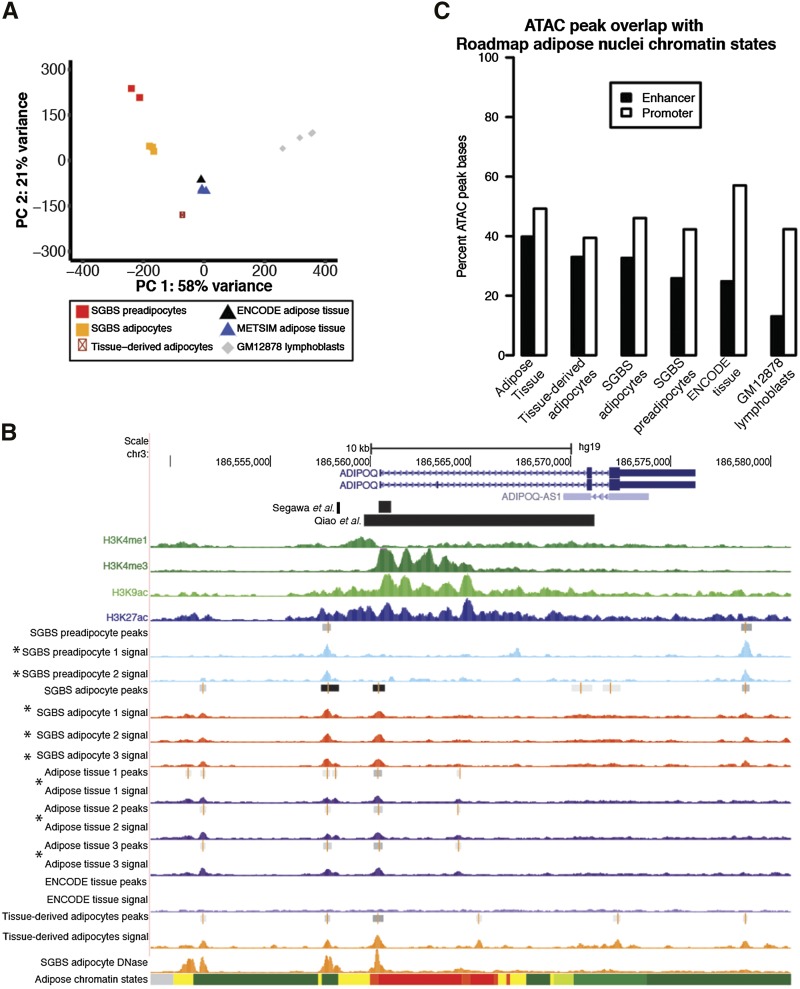
Comparison of ATAC-seq read profiles and peaks between samples and with Roadmap adipose nuclei chromatin states. (A) Principal component analysis (PCA) of ATAC-seq read counts within representative peaks. (B) UCSC genome browser image (hg19) showing the ADIPOQ gene regions. ChIP-seq for histone marks from the Roadmap Epigenomics project adipose nuclei are shown at the top in green and blue. ATAC-seq signal tracks are shown in different colors by source: SGBS preadipocytes in light blue, SGBS adipocytes in red, adipose tissue in purple, ENCODE adipose tissue in light purple, and tissue-derived adipocytes in orange. DNase hypersensitivity signal tracks for SGBS adipocytes are also shown in orange. Asterisks represent ATAC-seq data generated in this manuscript. Peak regions are indicated by gray bars. The bottom track shows chromatin states from the Roadmap Epigenomics Project for adipose nuclei (yellow = enhancer; green = transcribed; orange/red = promoter; light green = genic enhancer; gray = repressed/polycomb; light red = bivalent/poised TSS; turquoise = heterochromatin). (C) Overlap of the top 50,000 ATAC-seq peaks with promoter and enhancer chromatin states identified in Roadmap adipose nuclei.